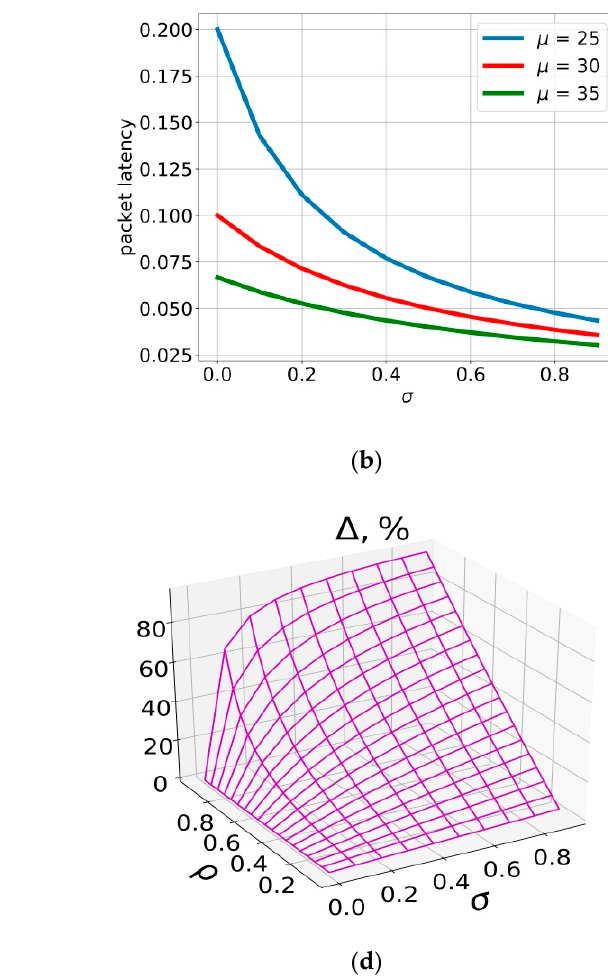
Figure 7. The cluster size’s allowed limit versus the packet latency defined by the quality of service (QoS) policy.